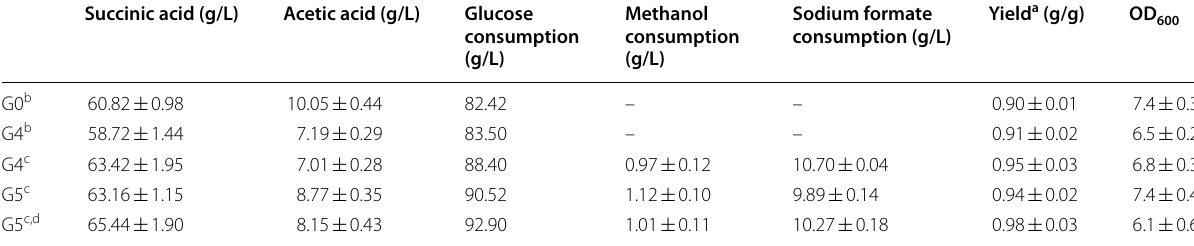
a Due to the volume expansion in fed-batch fermentation, the measured glucose consumption in real time could not reflect the true yield. Real glucose consumption was calculated by dividing the total added glucose by the final total volume, which would be lower than the measured value b Fermentation with pure glucose feeding c Fermentation with methanol and sodium formate co-feeding d Biofilm-based cell-immobilized fermentation